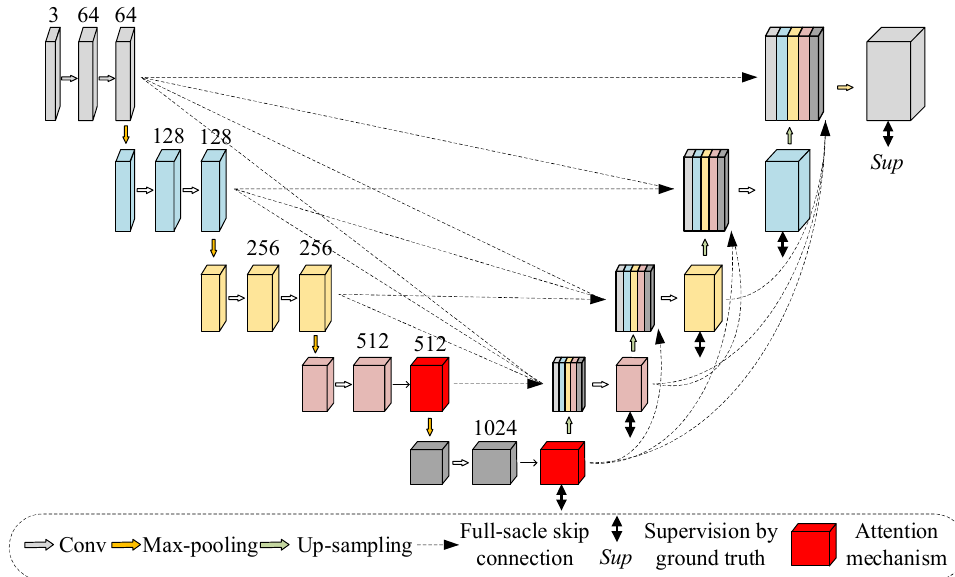
Figure 4. The network architecture of the generator.